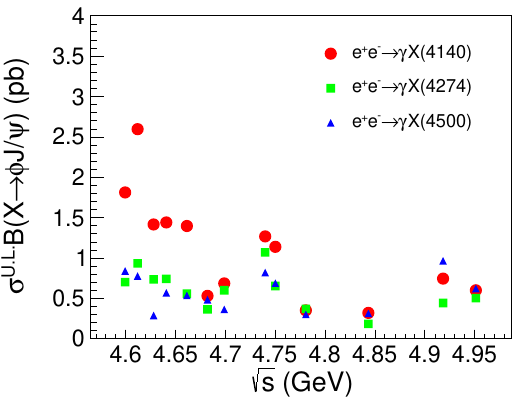
Figure 8 . The upper limit of Born cross section product branching fraction at the 90% C.L. versus c.m. energy for e + e − → γX (4140) /γX (4274) /γX (4500)